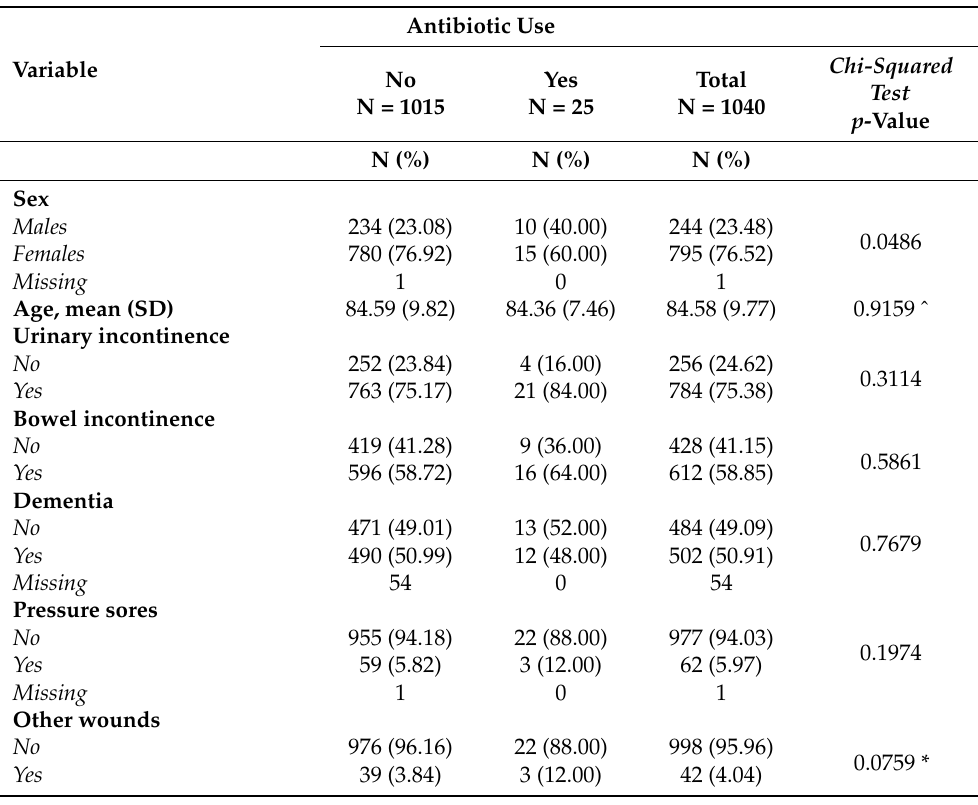
Table 3. Distribution of LCTF residents’ clinical and demographic characteristics and the p -value of the test used to evaluate the relationship between patients’ characteristics and antibiotic use.